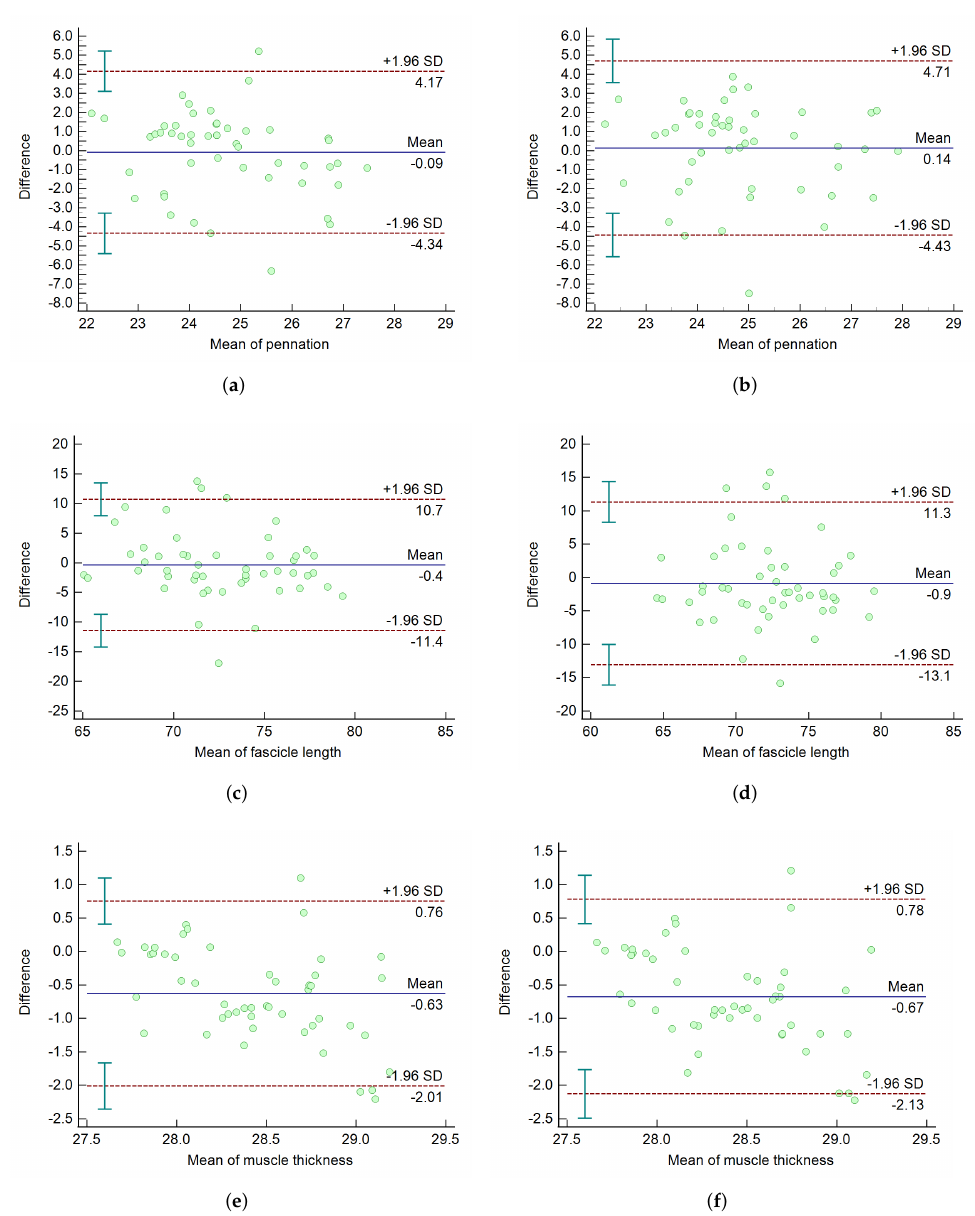
Figure 11. The Bland–Altman plots of the DL method and our method. ( a , c , e ) is the Bland-Altman plots of our method versus the manual method. ( b , d , f ) is the Bland-Altman plots of the DL method versus the manual